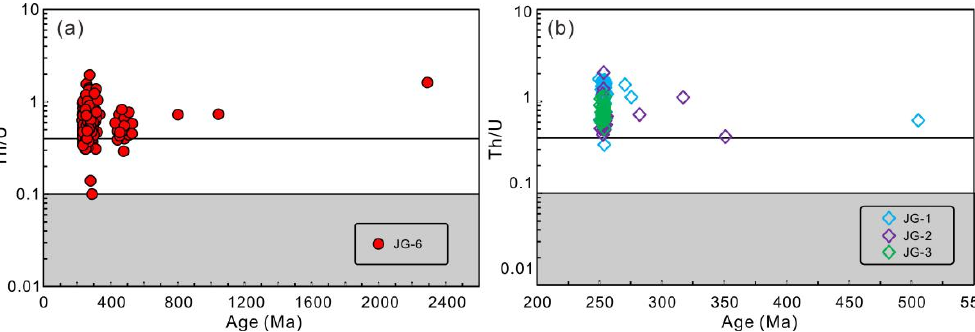
Figure 7. Th/U ratio vs. U-Pb ages diagram for zircons from the ( a ) conglomerate and ( b ) granitic pebbles in the conglomerate. The shaded area denotes values for typical metamorphic zircons with Th/U < 0.1.